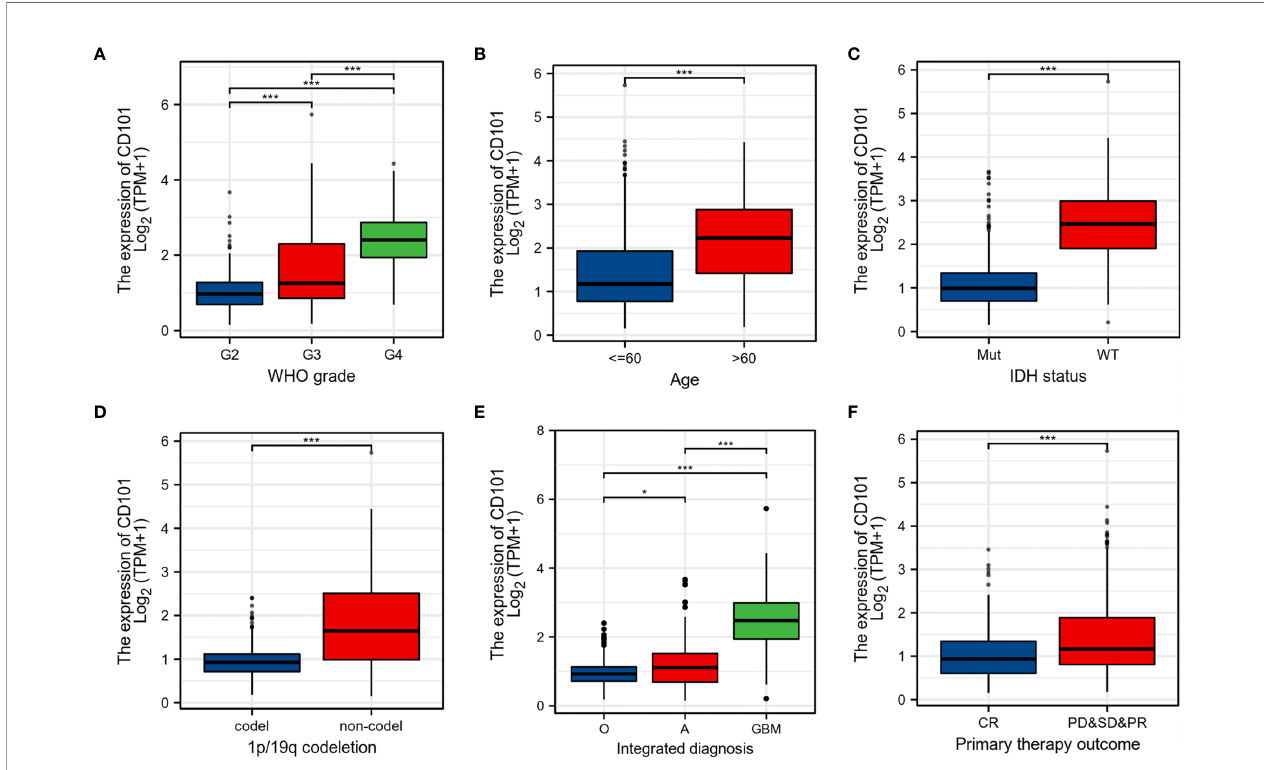
FIGURE 2 | Associations between CD101 expression and different clinical characteristics in glioma. (A) Histological grade. (B) Age. (C) IDH mutation status, Mut: IDH-mutant; WT: IDH-wild type. (D) 1p/19q codeletion status. (E) Integrated diagnosis, O: oligodendroglioma, IDH-mutant, and 1p/19q-codeleted; A: astrocytoma, IDH-mutant; GBM: glioblastoma, IDH-wild type. (F) Primary therapy outcome (* p < 0.05, *** p <